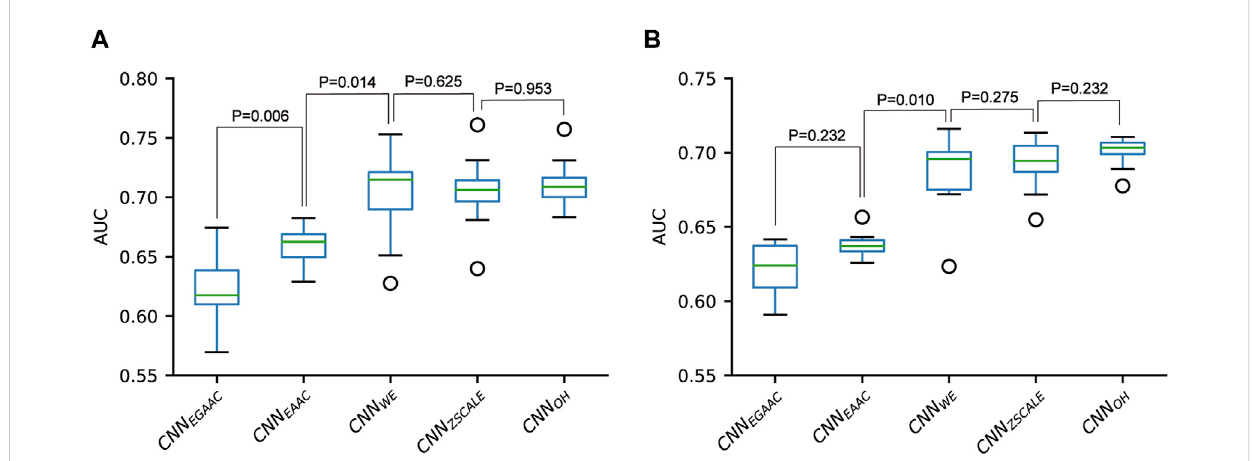
FIGURE 7 Performance comparison of CNN-based classi fi ers built for the pSADPr-SADPr dataset in ten-fold cross-validation (A) and independent test (B)